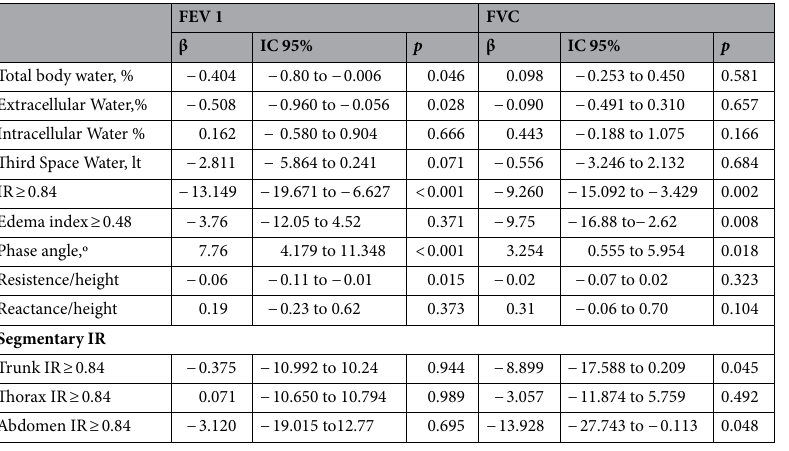
Table 2. Impact of hydration status and fluid distribution over pulmonary function . IR Impedance ratio. Variables were adjusted by sex, height, and